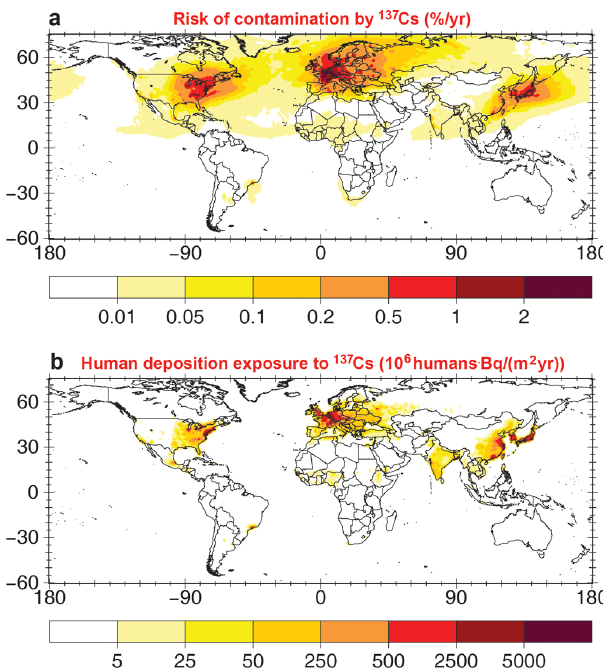
Fig. 2. Global risk of radioactive contamination by 137 Cs. (a) Based on the modelled deposition of ≥ 40kBq 137 Csm − 2 yr − 1 . The risk is the expected value normalized by 40kBqm − 2 . (b) Modelled risk of human exposure to 137 Cs